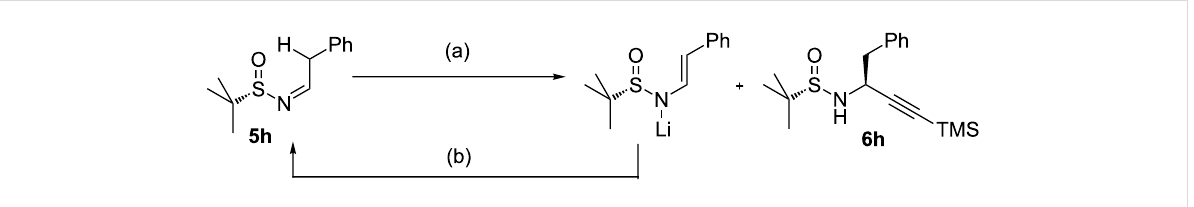
Figure 5: Reaction of N- sulfinylimine 5h with (trimethylsilyl)ethynyllithium. (a) GP-3 or GP-4. (b) Aqueous work-up, H 2 O/H + . Deprotonation in benzylic position competes with nucleophilic attack ( 5h / 6h , 7:3).